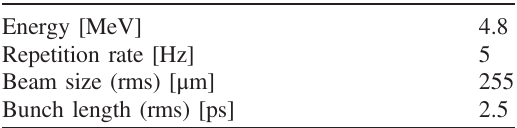
TABLE I. Typical parameters of the electron beam.